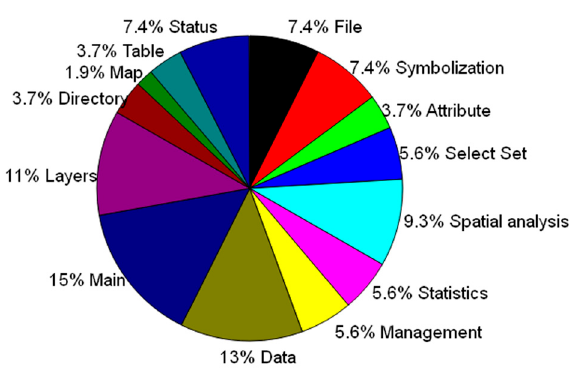
Figure 13. The distribution of various functions of the desktop. At present, the distribution of various functions is relatively balanced, covering almost all aspects of desktop GIS applications. All features are tailored to data clusters and enable a rapid integration of geospatial data in a distributed environment.